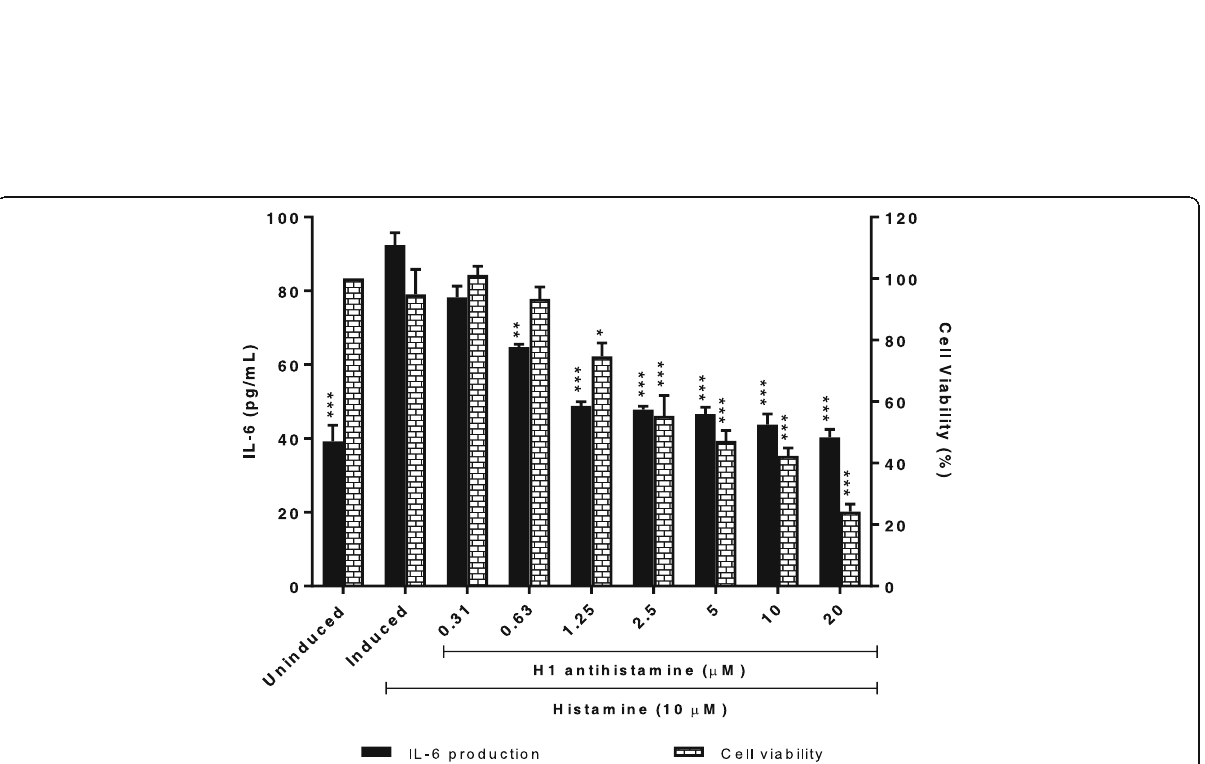
Fig. 3 Effects of H1 antihistamine on IL-6 production and cells viability of histamine-induced HaCaT cells. Cells were seeded for 24 h before inducing with 10 μ M of histamine. H1 antihistamine was tested in two-fold serial dilution with the highest concentration of 20 μ M. Cells were then futher incubated for 24 h. All values are the mean ± S.E.M. of three independent experiments. Values of * P < 0.05, ** P < 0.01 and *** P < 0.001 were considered significantly different to histamine-induced control group